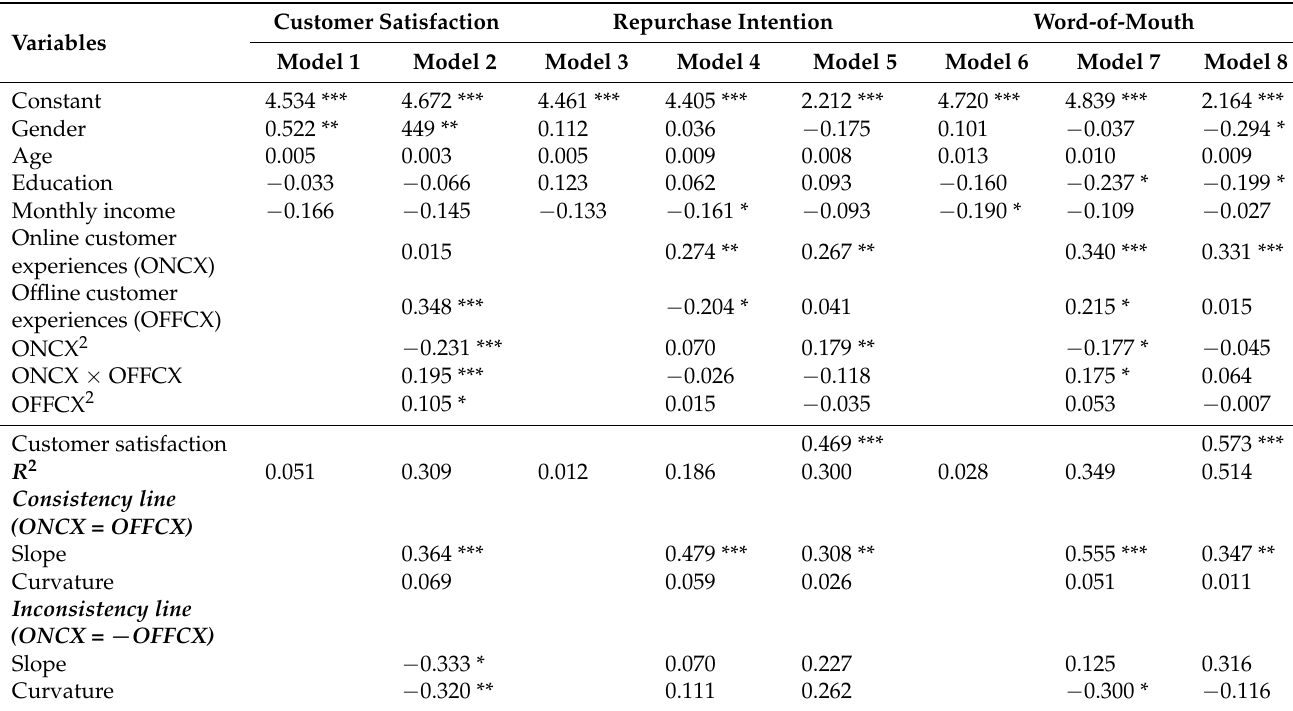
Table 4. Polynomial regression